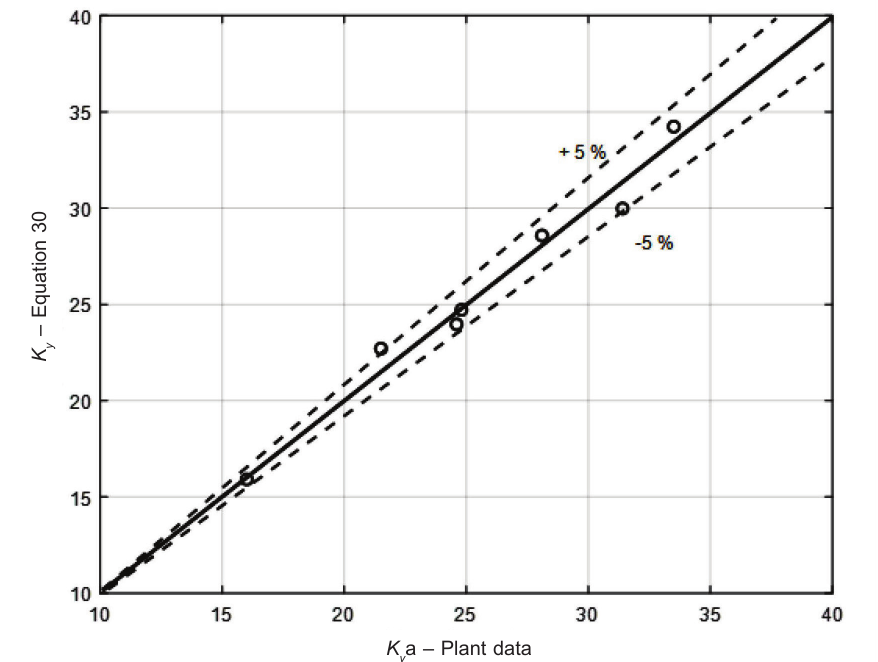
Fig. 11 – Stripping column: K a values, kmol m –3 h –1 , predicted by Equation 30 versus experimental data y Note: β = 30.1; β = 0.407; β = 1 2 3